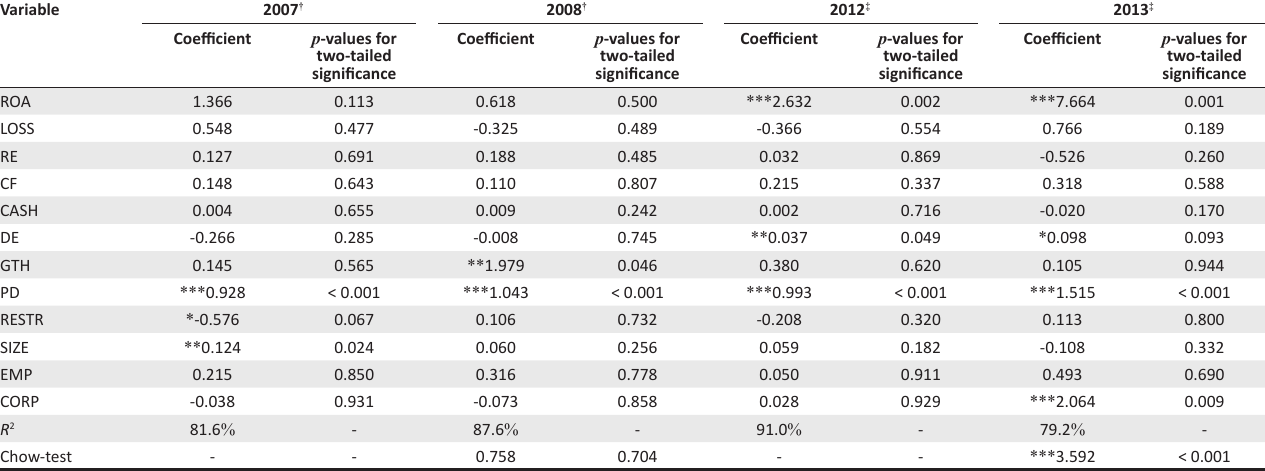
TABLE 5: Regression results determined independently per